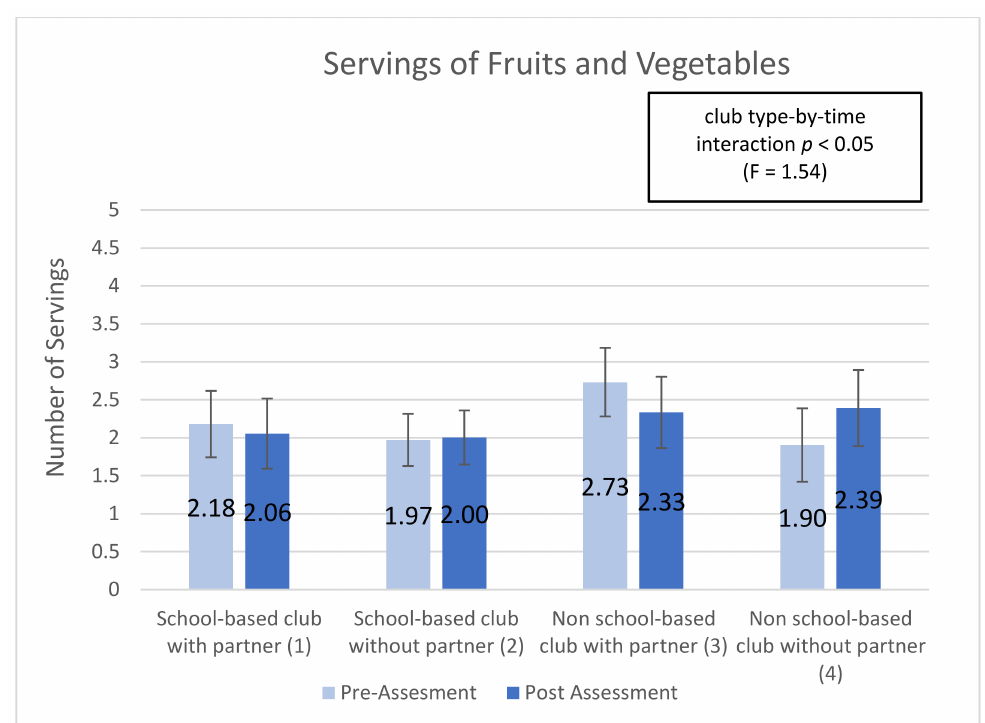
Figure 5. Servings of Fruits and Vegetables pre- post-assessments by club type and partnership.